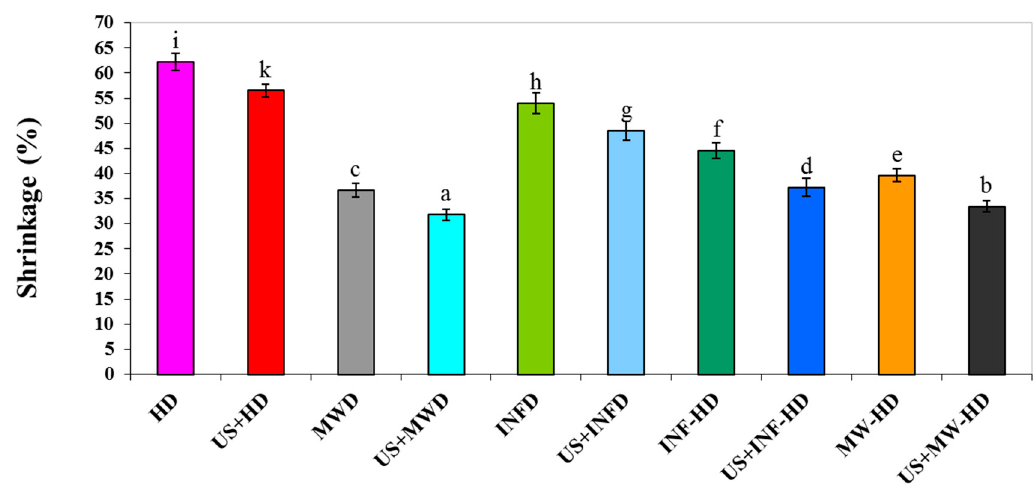
Figure 4. Shrinkage of the carrot samples by the different drying methods.